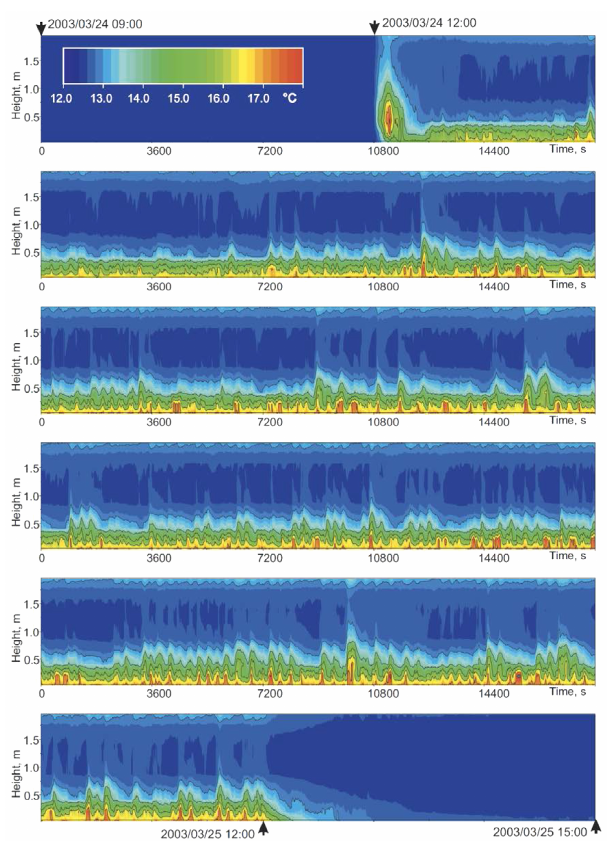
Figure 11. Temperatures before, during, and after the A3 heating experiment in space–time domain: temperature color-coded in ◦ C; on the vertical axis the position of the sensors is represented on the vertical bar (from 10 at the bottom to 1 on the top).